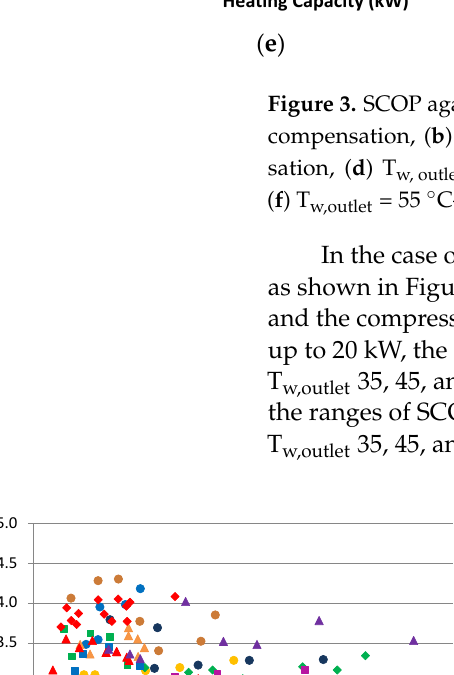
Figure 3. SCOP against HP’s heating capacity for the city of Ierapetra: ( a ) Τ w,outlet = 35 °C — without compensation, ( b ) Τ w,outlet = 35 °C — with compensation, ( c ) Τ w,outlet = 45 °C — without compensation, ( d ) Τ w, outlet = 45 °C — with compensation, ( e ) Τ w,outlet = 55 °C — without compensation, ( f ) Τ w,outlet = 55 °C — with compensation.